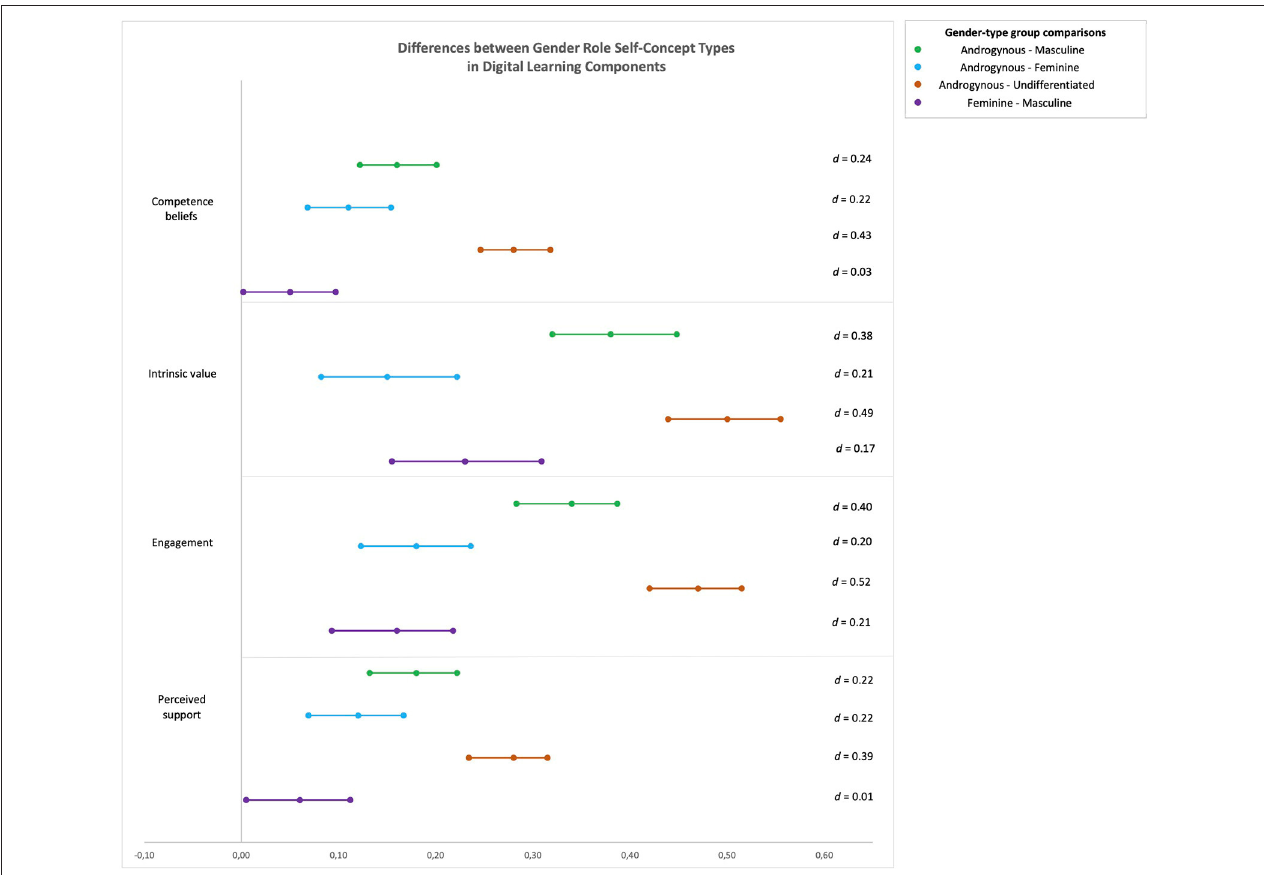
FIGURE 2 | Mean differences and two-sided 95% confidence intervals for the gender role self-concept group comparisons in four digital learning components. The x-axis shows the confidence interval span. The point estimate is the mean difference between gender role self-concept types (gender-type groups) in observed digital learning components. Cohen’s d indicates effect size for the comparison between two means. Positive values indicate advantage of androgynous over masculine, feminine, and undifferentiated adolescents in observed digital learning components, and advantage of feminine over masculine adolescents in observed digital learning